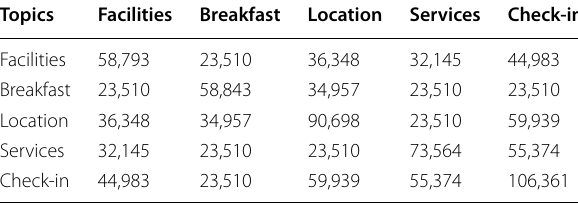
Note: This table is based on the review data of four-star hotels on the Ctrip hotel platform